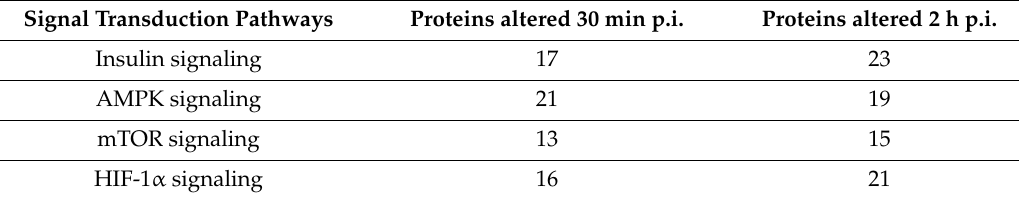
Table 1 highlights the number of signaling proteins that are similarly altered in chicken macrophages infected with S. Enteritidis and S. Heidelberg at 30 min and 2 h p.i. Table 1. Salmonella alters the phosphorylation of proteins in key immunometabolic pathways.